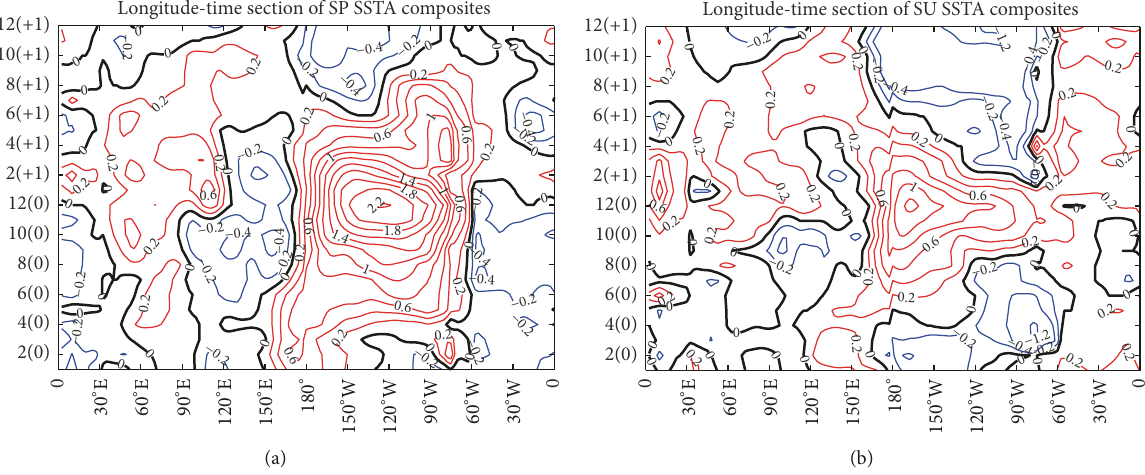
Figure 2: Longitude-time section of composite SSTA near the equator (5 ∘ S–5 ∘ N) for (a) SP and (b) SU El Ni˜no, in which the black contours indicate the mean value, the red contours indicate positive anomalies, and the blue contours indicate negative anomalies.